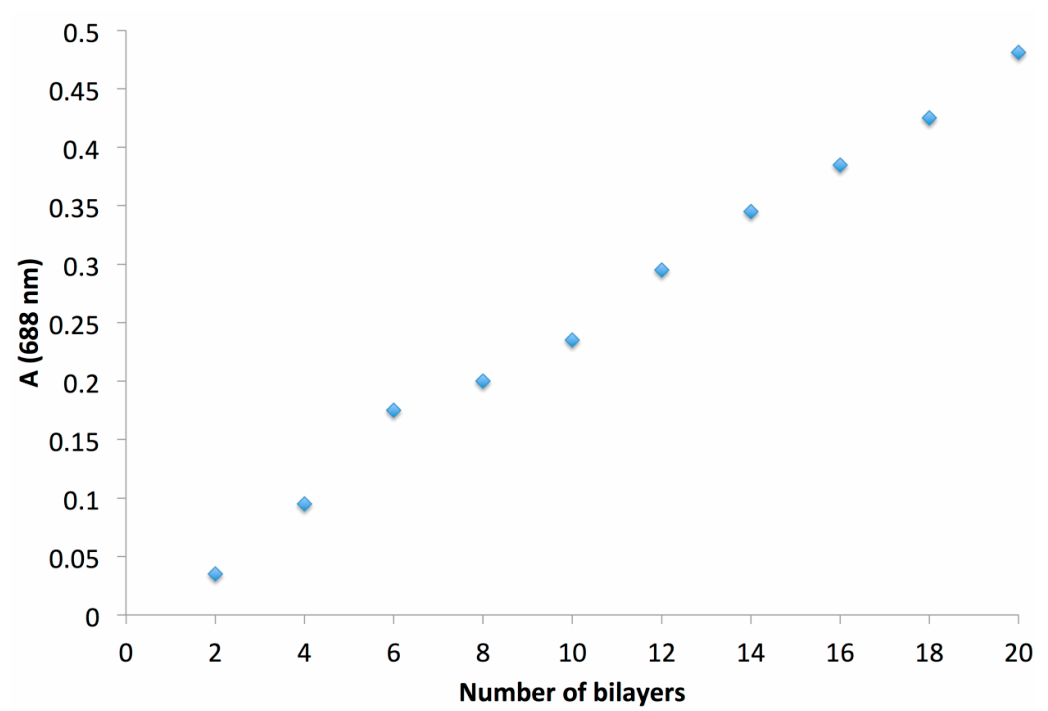
Figure 9. Absorbance measured at 688 nm, with the baseline correction, against the number of (PANI/CuTsPc) bilayers n